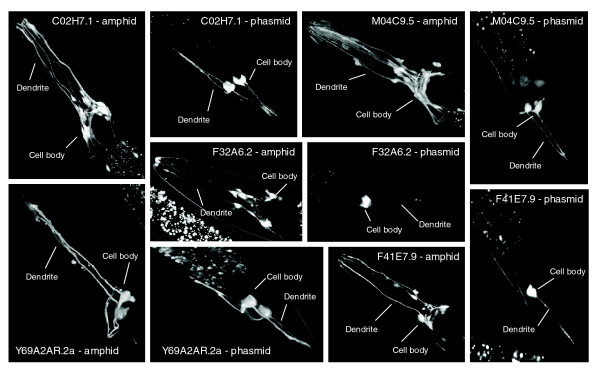
The X-box-containing genes Y69A2AR.2a, C02H7.1, F41E7.9, F32A6.2 and M04C9.5 are expressed exclusively within ciliated cells. Shown are green fluorescent protein (GFP) fluorescence images of the head (for example, amphid cell region) and tail (for example, phasmid cell region) regions of worms expressing transcriptional GFP reporters to the indicated genes. In all cases, expression is observed only within ciliated neuronal cells such as the amphid head cells and the phasmid tail cells.